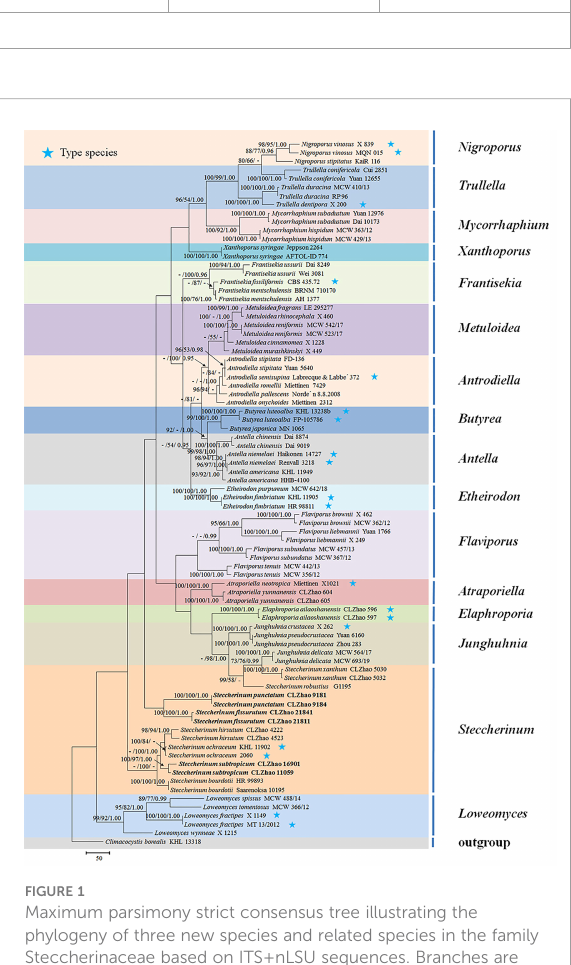
FIGURE 1 Maximum parsimony strict consensus tree illustrating the phylogeny of three new species and related species in the family Steccherinaceae based on ITS+nLSU sequences. Branches are labeled with maximum likelihood bootstrap values higher than 70%, parsimony bootstrap values higher than 50% and Bayesian posterior probabilities more than 0.95